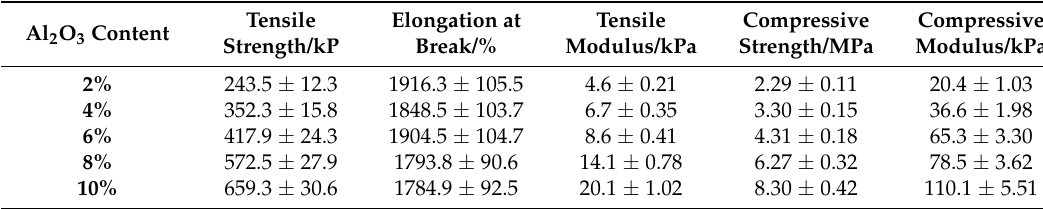
Figure 3. ( a ) Photo illustration of the mechanical properties of PAS gels; ( b ) typical tensile and ( c ) compressive stress–strain curves of PAS gels with different Al 2 O 3 content. Table 1. Mechanical properties of PAS